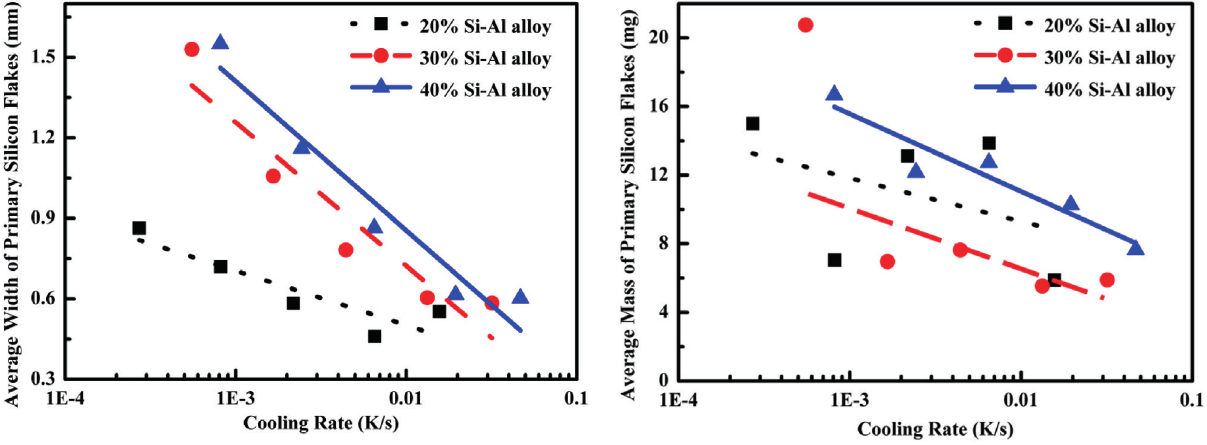
Fig. 4: Average width of primary silicon flakes Fig. 5: Average mass of primary silicon flakes